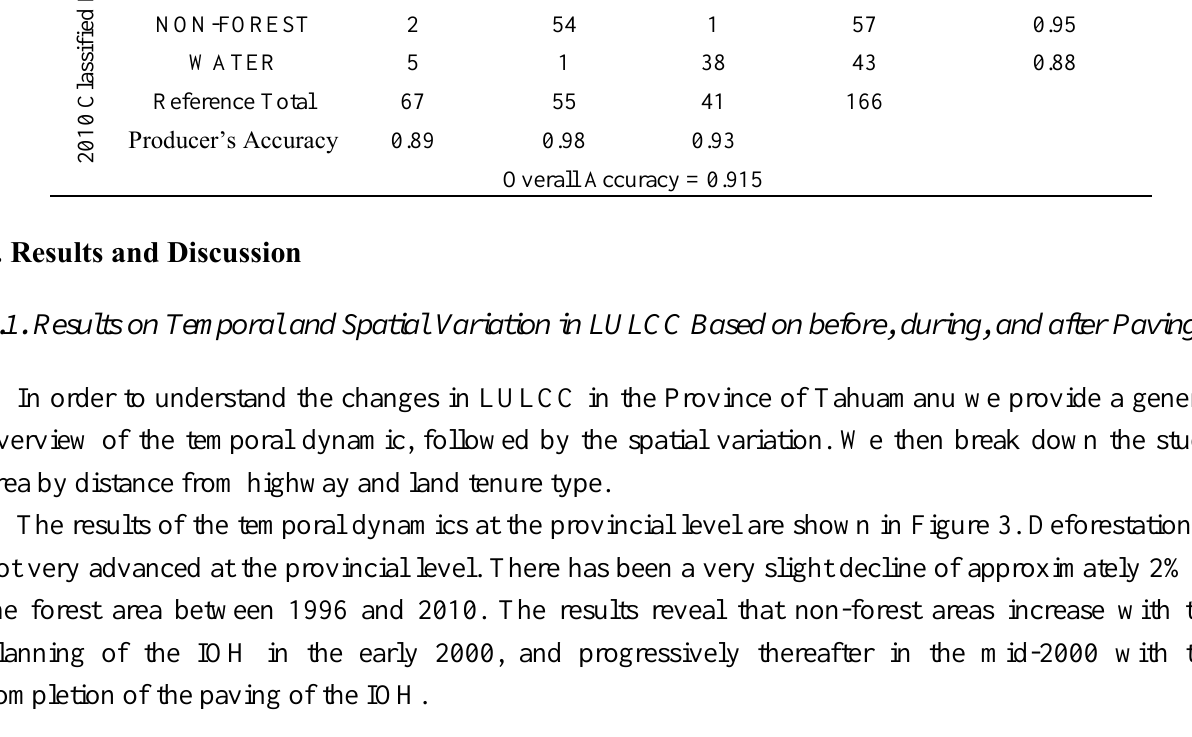
Figure 3. Forest, non-forest and water land-cover change temporal dynamic for 1996, 2001, 2006, 2011 for the Province of